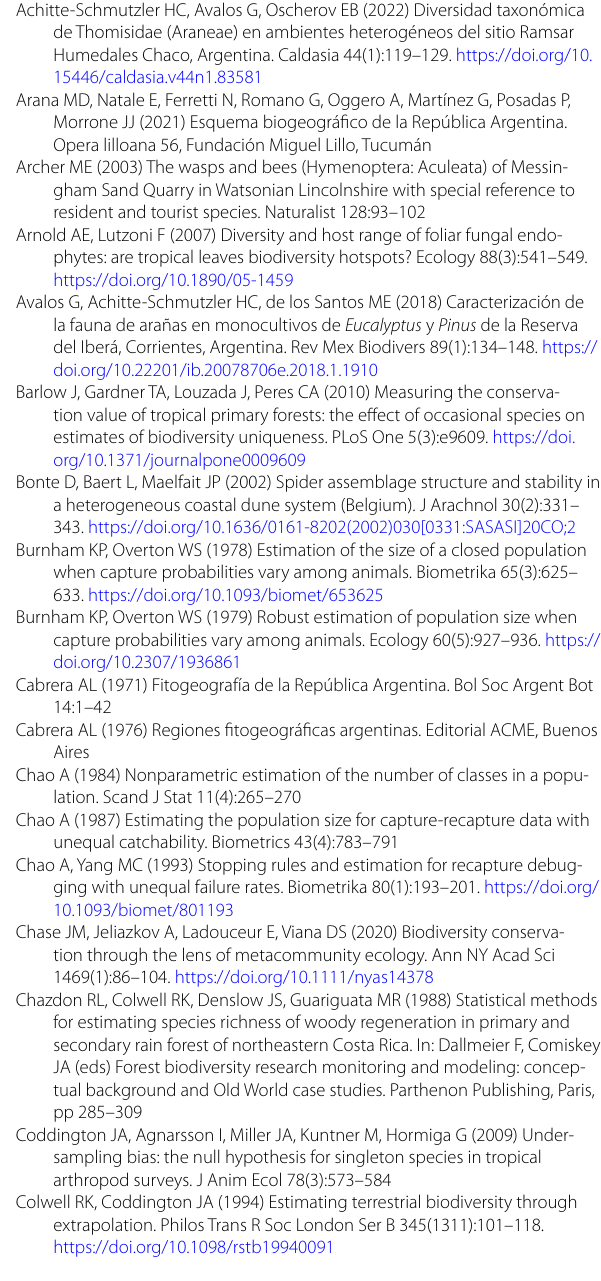
species were considered or not. Table S4 . Significance assessment of the differences between the richness overestimation data, calculated as the difference between observed and estimated richness, when adults were considered or not. Table S5 . Average values of the final slopes of the richness estimation curves, when adults were considered or not. Table S6. Significance assessment of the differences between the data of final slopes of richness estimation, when adults were considered or not. Additional file 2: Table S1. Difference between observed and estimated richness when habitat-tourist species were considered. Table S2. Differ- ence between observed and estimated richness when habitat-tourist spe- cies were not considered. Table S3. Verification of the normality assump- tion of the richness overestimation data, calculated as the difference between observed and estimated richness. Table S4. Values of the final slopes of the richness estimation curves when habitat-tourist species were considered. Table S5. Values of the final slopes of the richness estimation curves when habitat-tourist species were not considered. Table S6. Verifi- cation of the normality assumption of the final slope data of the richness estimation